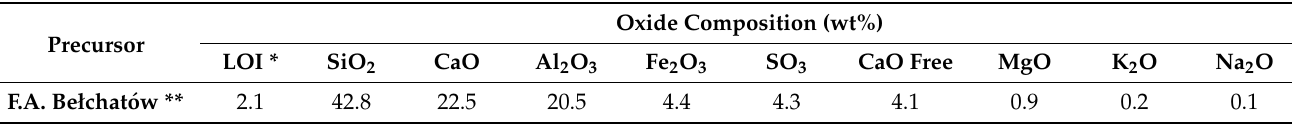
Table 1. Oxide composition of the Belchat ó w lignite fly ash.